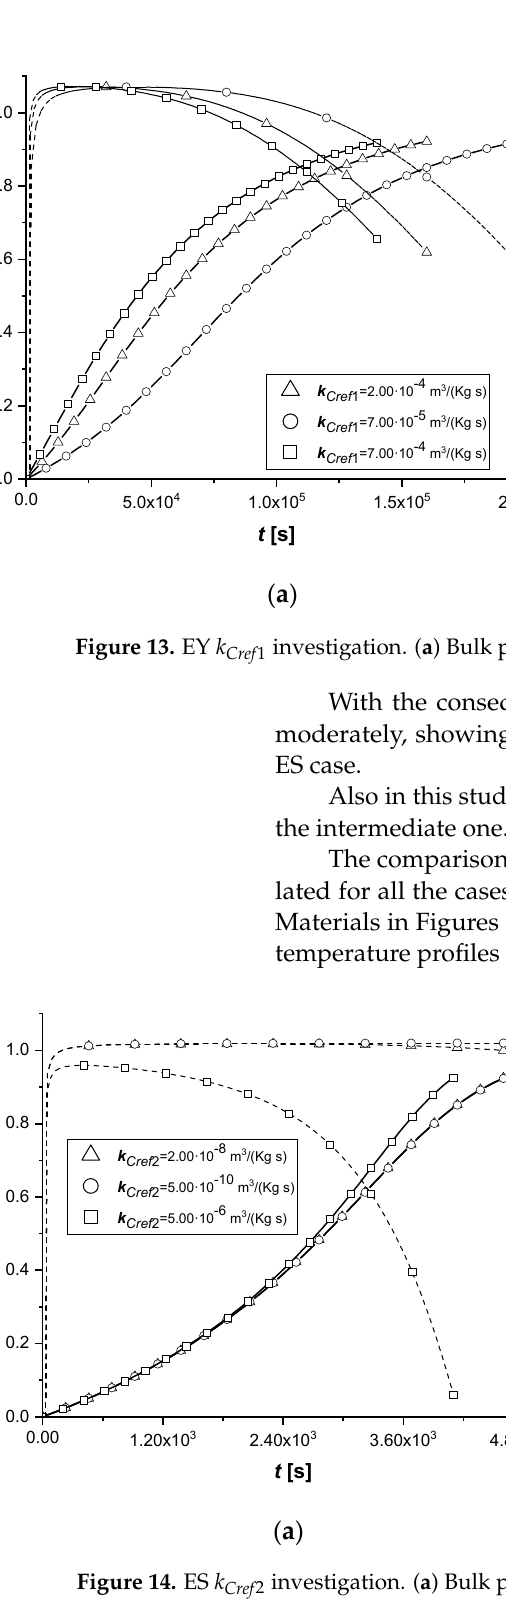
Figure 14. ES k Cref 2 investigation. ( a ) Bulk profiles over time of X A and S B . ( b ) Bulk profile of T l over time.